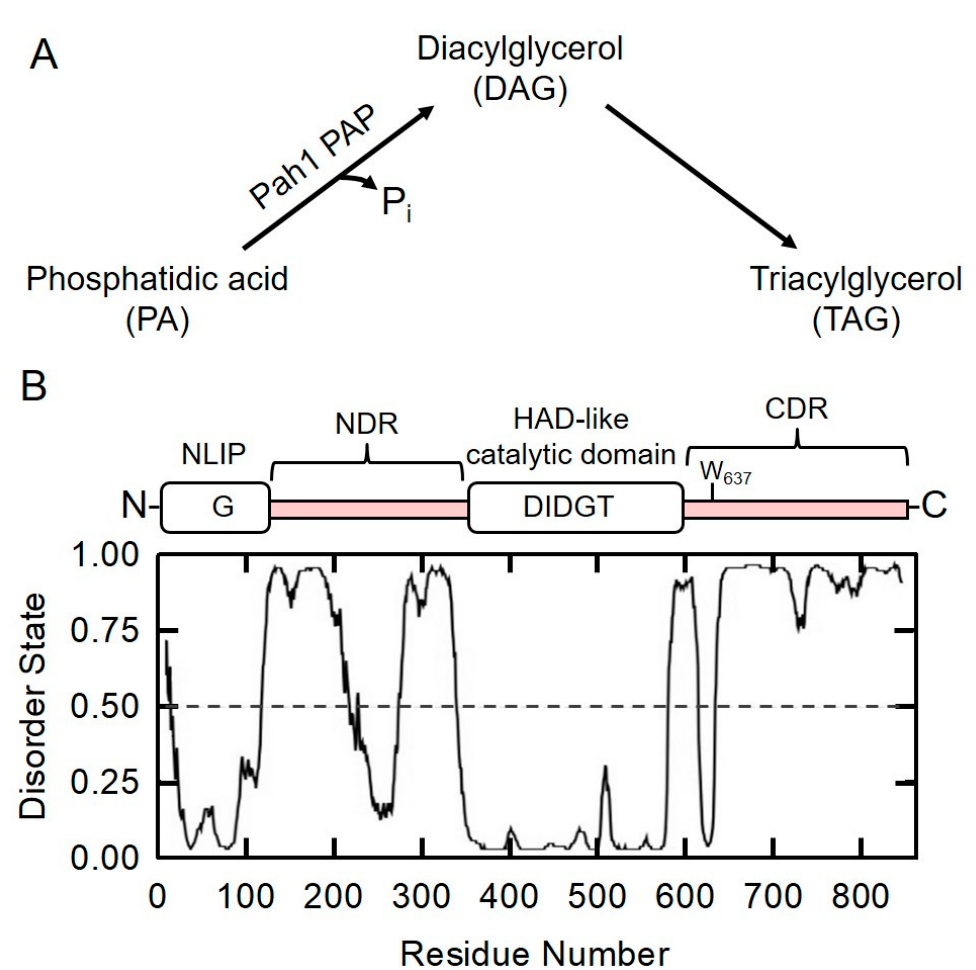
Figure 1. The reaction catalyzed by the yeast Pah1 phosphatidate phosphatase is shown ( A ). Pah1 PAP catalyzes the dephosphorylation of phosphatidic acid (PA) to produce diacylglycerol (DAG) for the biosynthesis of triacylglycerol (TAG). The domain structure and prediction of intrinsically disordered regions in Pah1 PAP are presented ( B ). N-terminal Lipin (NLIP) and haloacid dehalogenase (HAD)-like domains are in the N-terminus and middle of Pah1, respectively; DIDGT is the catalytic motif in the HAD-like domain. Besides the conserved regions, there are two non-conserved regions, namely N-terminal disordered region (NDR, residues 99–359) and C-terminal disordered region (CDR, residues 592–862). The Pah1 sequence was analyzed using the DISOPRED3 algorithm (http://bioinf.cs.ucl.ac.uk/psipred/) (accessed on 1 March 2020).